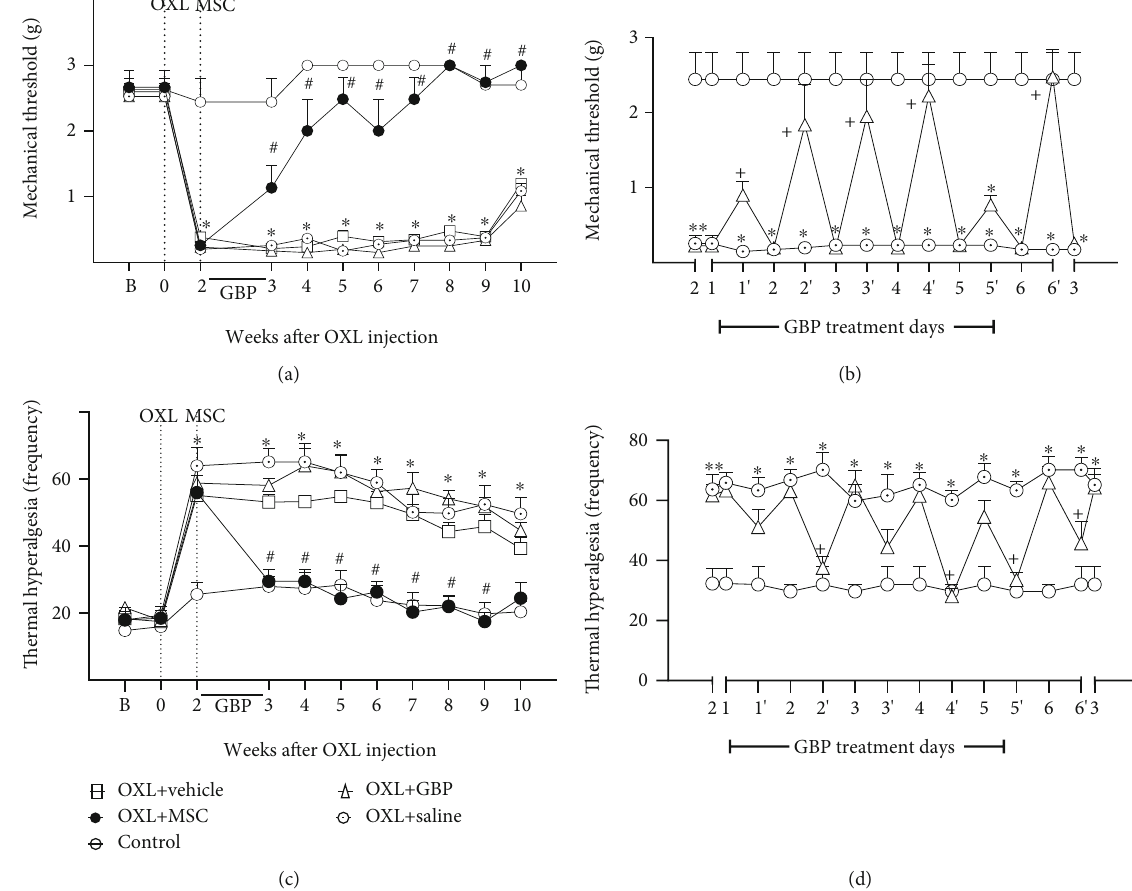
Figure 1: Pain-like behaviors of mice treated with MSC or gabapentin on the OXL-induced painful neuropathy model. (a, b) show mechanical nociceptive threshold data: the strength of the fi lament (grams) in which the animal responds in 50% of the presentations ( y -axis) in relation to time ( x -axis), given in weeks (a) or days (b), after induction of the neuropathy model. (c, d) show cold thermal hyperalgesia data: the frequency of nociceptive behaviors ( y -axis) in relation to time ( x -axis), given in weeks (c) and days (d), after OXL induction. The nociceptive threshold was evaluated in the mice before (b) and after OXL induction (week 0). The control group represents nonneuropathic mice that received vehicle (5% dextrose) instead of OXL. Two weeks after the model induction, mice were intravenously treated with MSC (OXL+MSC; 1 × 10 6 /100 μ L ) or vehicle (OXL+vehicle; 100 μ L) or orally treated with gabapentin (OXL+GBP; 70mg/kg; 12/12 h; 6 consecutive days) or saline (OXL+saline; 12/12h; 6 consecutive days). During the 6 days of GBP treatment, nociceptive thresholds were daily assessed in two moments: immediately before and one hour after the GBP administration. (b, d) show nociceptive threshold data before (time points 1, 2, 3, 4, 5, and 6) and after (time points 1 ′ , 2 ′ , 3 ′ , 4 ′ , 5 ′ , and 6 ′ ) the administration of GBP. Data are expressed as means ± standard deviation ; n = 6 mice per group. ∗ Statistical signi fi cance relative to the control group ( p < 0 : 001 ); # statistical signi fi cance relative to the OXL+vehicle group ( p < 0 : 001 ); + statistical signi fi cance relative to the OXL+saline group ( p < 0 : 05 ), as determined by two-way ANOVA followed by Bonferroni